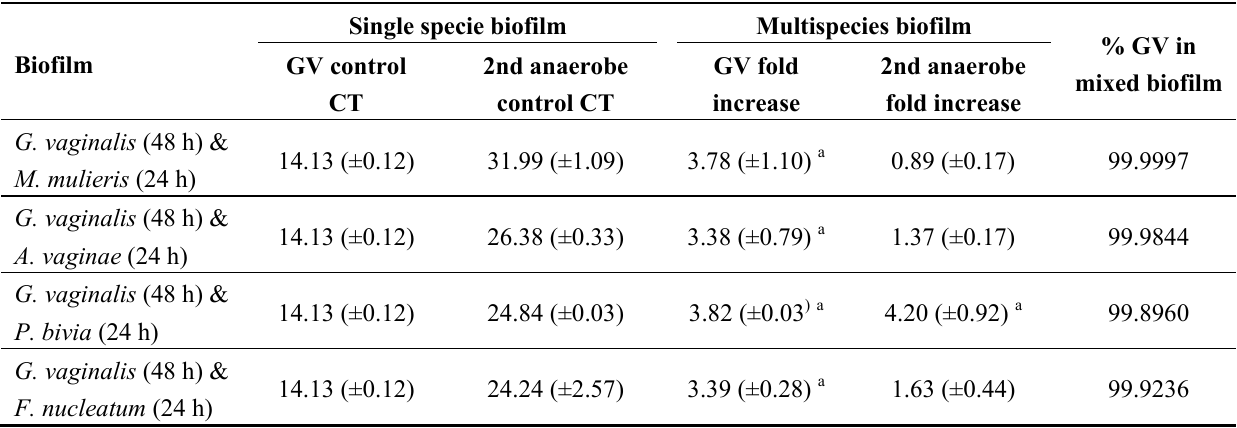
Table 3. Results of the quantitative PCR (qPCR) from mixed biofilm formation assays with Gardnerella vaginalis 101 and a second BV anaerobe. All experiments were done in